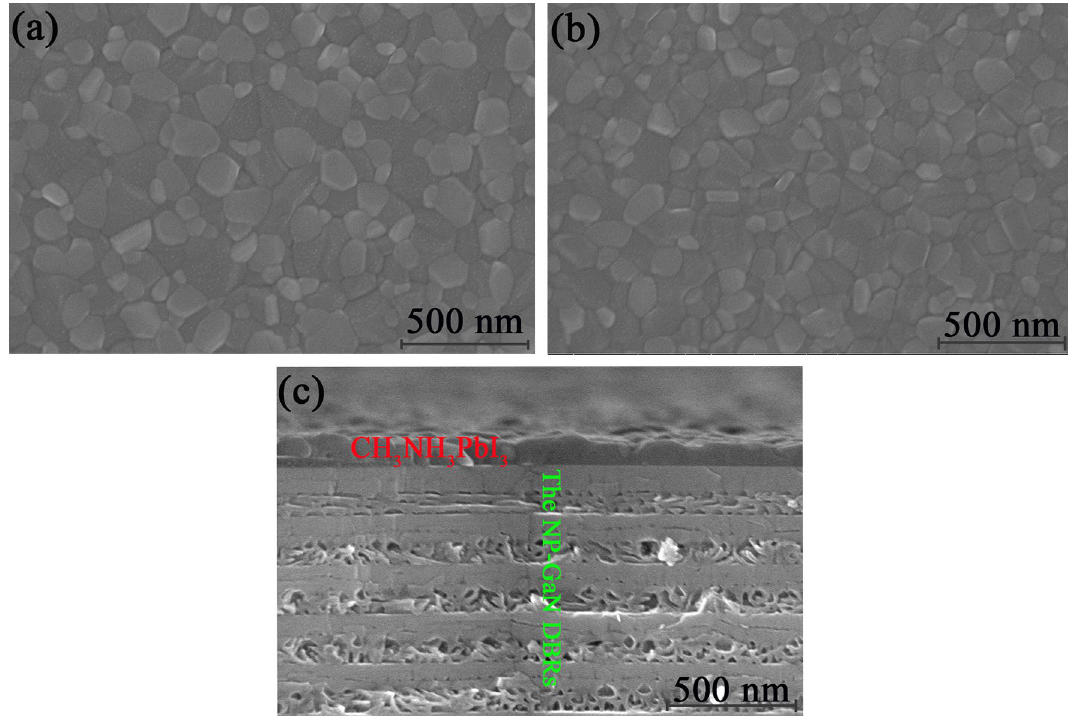
Figure 4. The top-view SEM morphology images of perovskite films grown on ( a ) the NP-GaN DBR and ( b ) as-grown GaN substrate by one-step solution method. ( c ) The cross-sectional SEM image of CH 3 NH 3 PbI 3 perovskite thin film grown on the NP-GaN DBR.